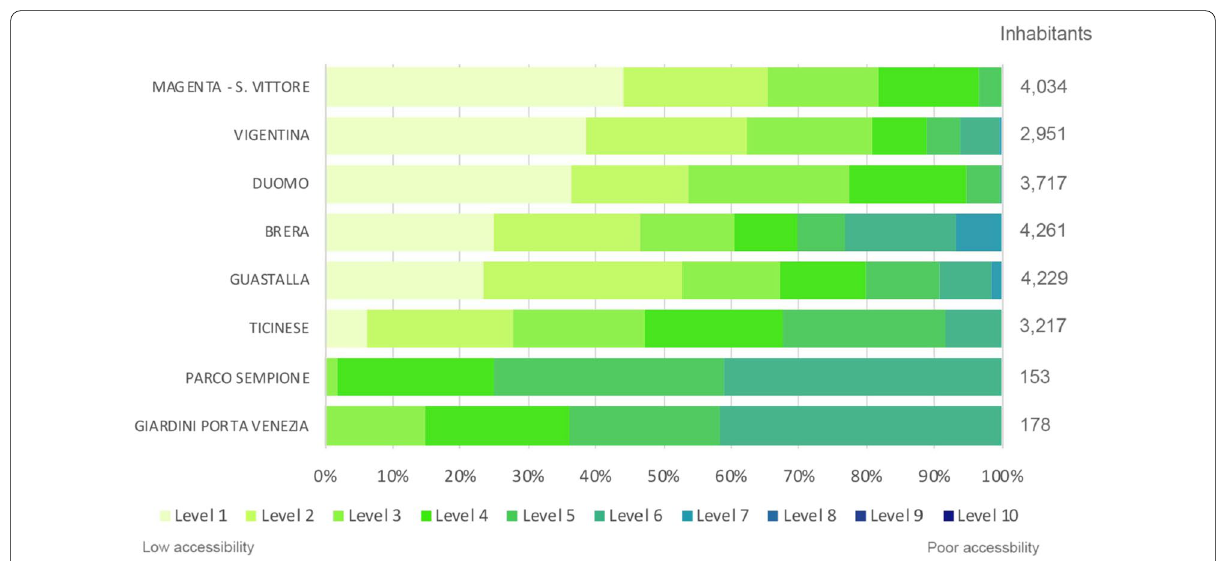
Fig. 9 The percentage of elderly people for each level of accessibility at the primary health centres in the Milan Central